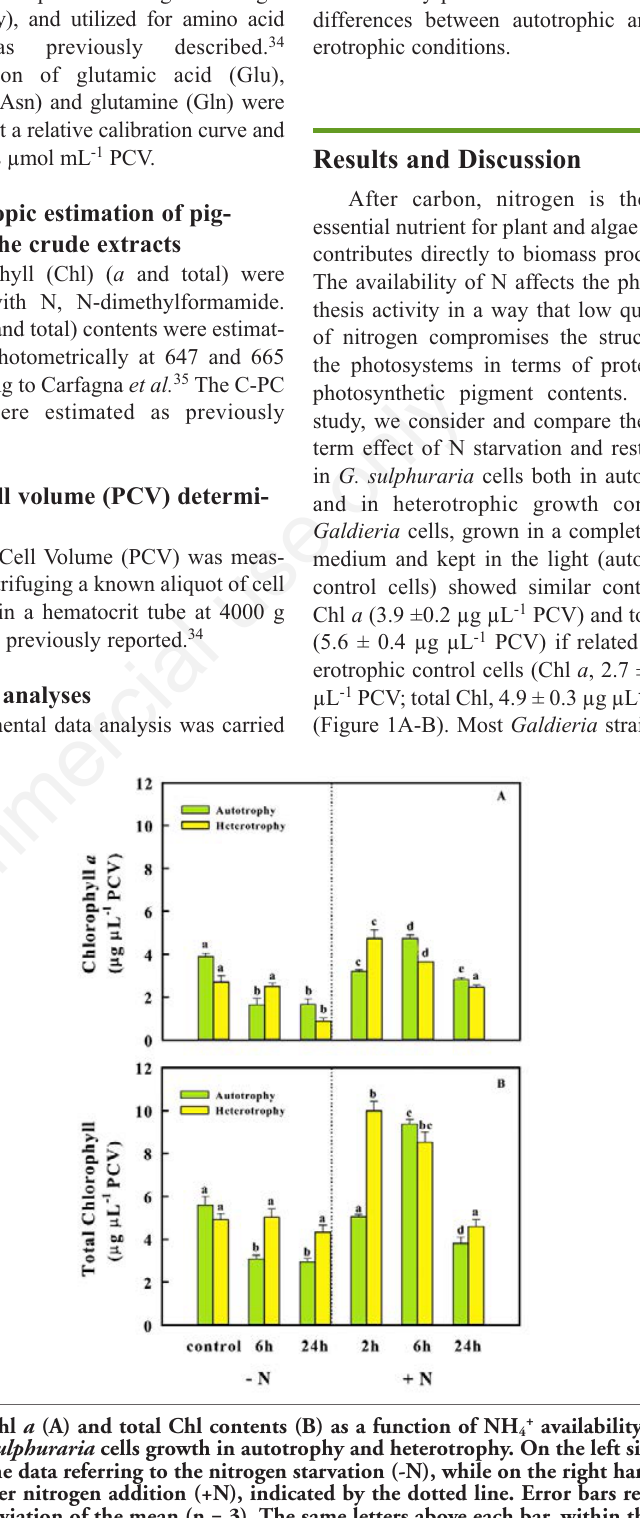
Figure 1. Chl a (A) and total Chl contents (B) as a function of NH Galdieria sulphuraria cells growth in autotrophy and heterotrophy. On the left side, it is indicated the data referring to the nitrogen starvation (-N), while on the right hand side, the data after nitrogen addition (+N), indicated by the dotted line. Error bars represent standard deviation of the mean (n = 3). The same letters above each bar, within the same graph, indicate non-significant differences (P ≤ 0.05, ANOVA, Tukey’s multiple compar-